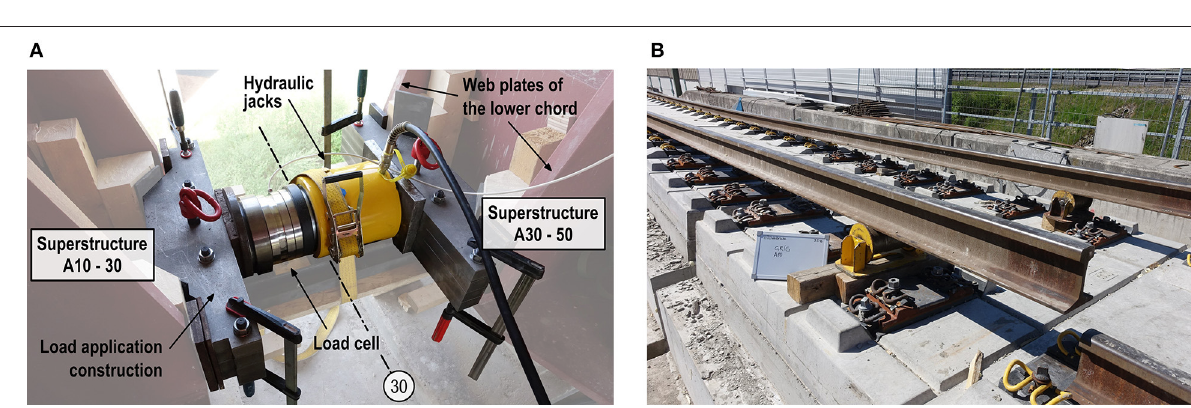
FIGURE 5 | (A) Hydraulic press, load cell, and load application construction. Source: Marc Wenner. (B) Rails close to the bridge joint were released to decouple the neighboring superstructure segments. Reproduced from Wenner et al. (2019) with permission from [Marc